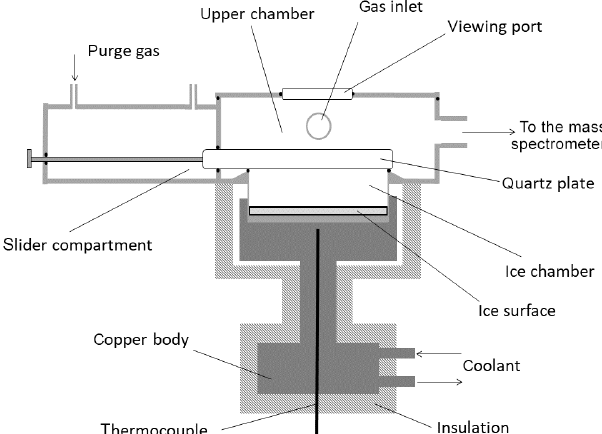
Figure 1. Schematic representation of the reactor used during the trapping experiments. An electrical heating element (not shown) is wrapped around the slider compartment and upper chamber to keep them at room